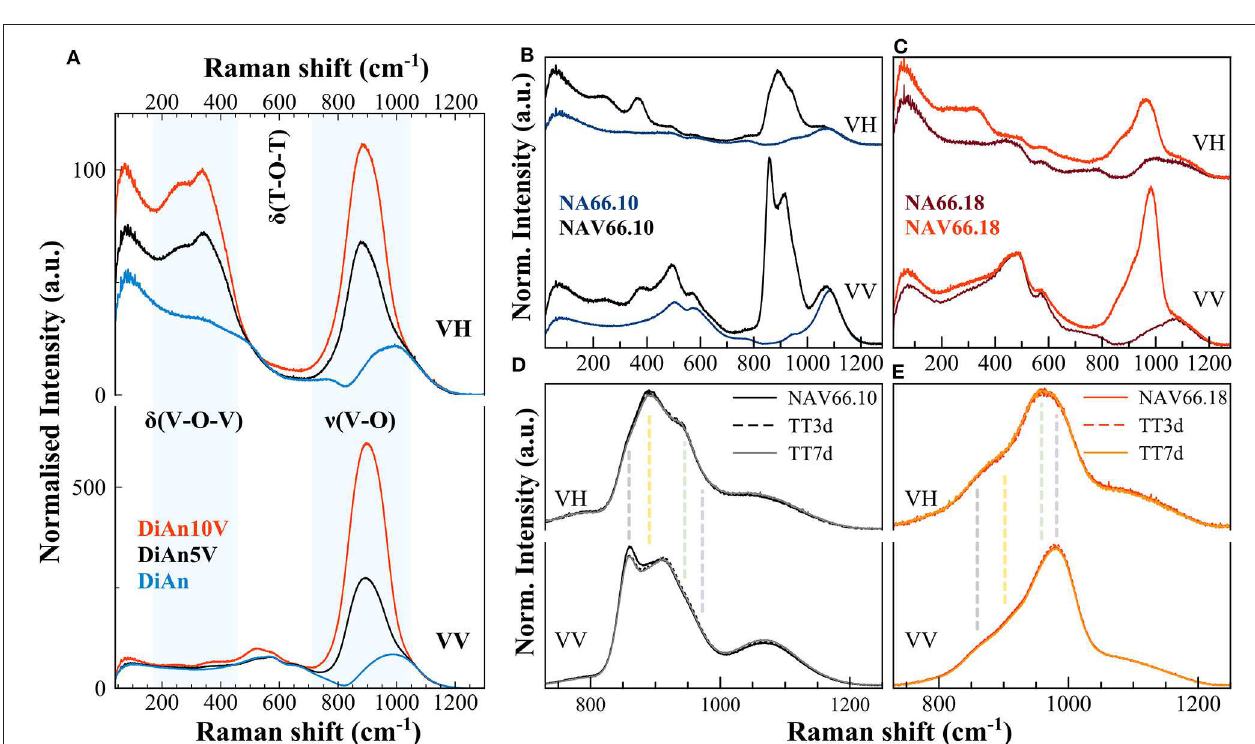
FIGURE 7 | (A–C) Parallel (VV) and cross-polarized (VH) Raman spectra of pristine and V-bearing DiAn and NAS glasses, respectively. Shaded areas highlight the vibrations related to the V networks. Si-O-Si ring and Si-O stretching motions are highly polarized bands; thus, their intensity drastically decreases when collected as cross-polarized. (D,E) Raman spectra of V-bearing NAS glasses after thermal treatments above Tg, of 3 (TT3d) and 7 days (TT7d). Vertical dashed lines highlight the different vibrations, each related to distinct V species (see text for details).